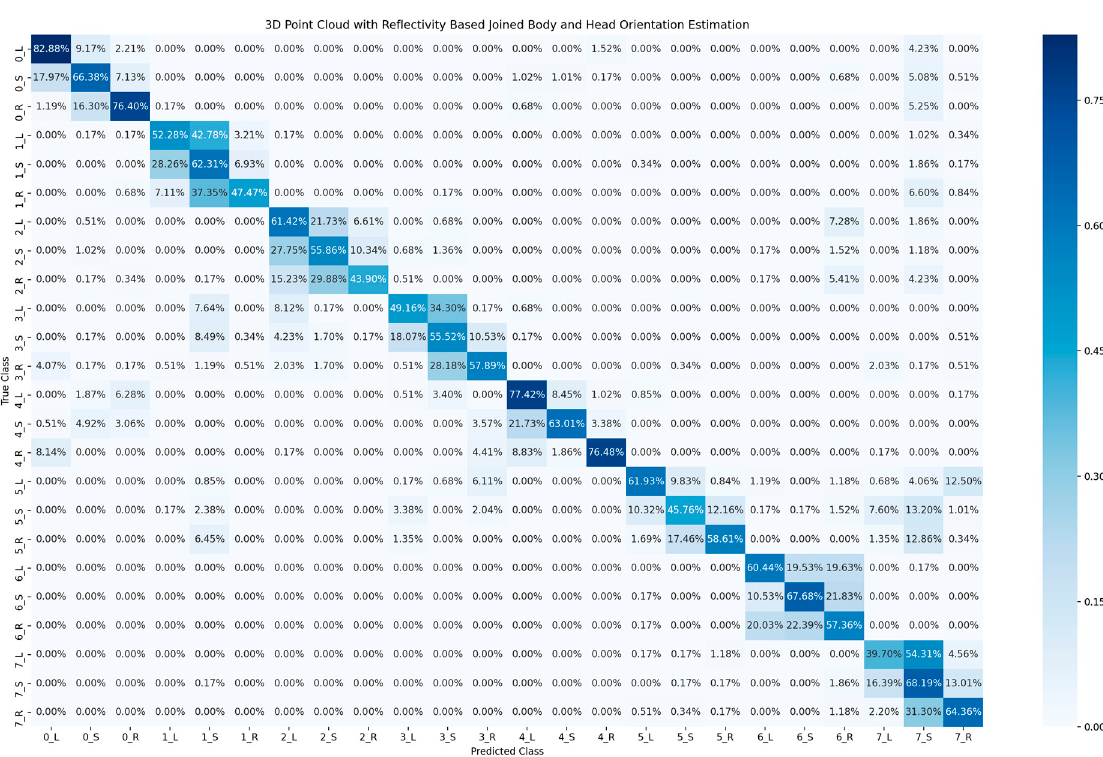
Figure 8. Confusion matrix of body orientation estimation accumulated from joined body and head orientation estimation using 3D point cloud data with ambient.